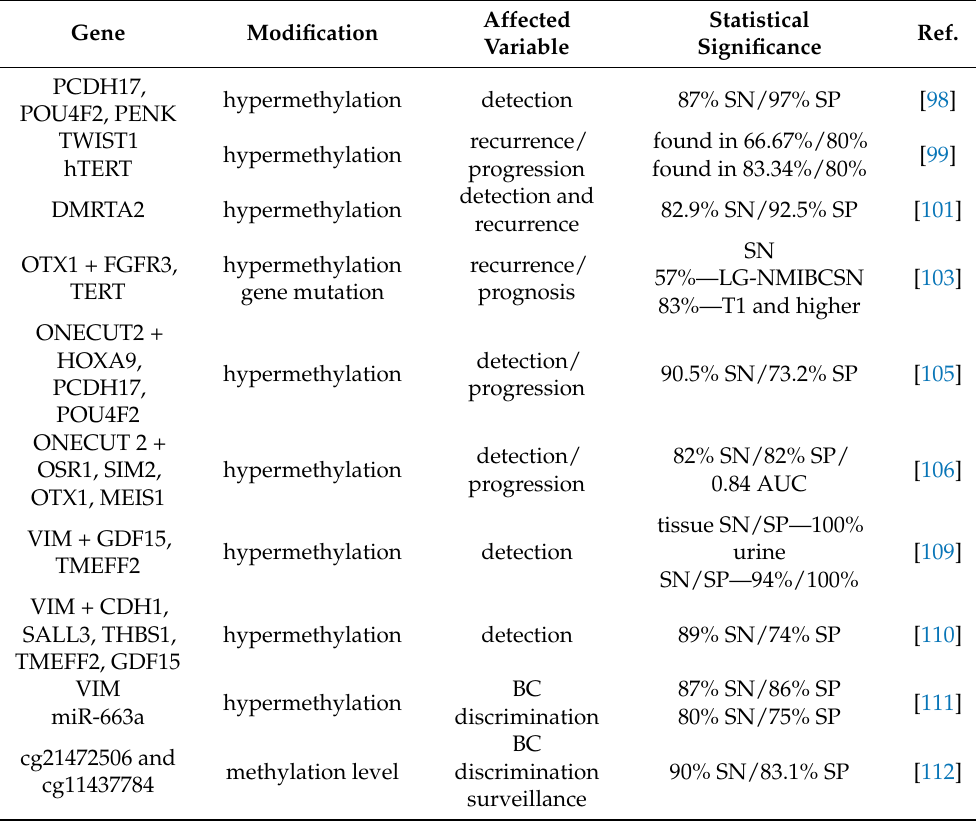
Table 3. The most promising epigenetic